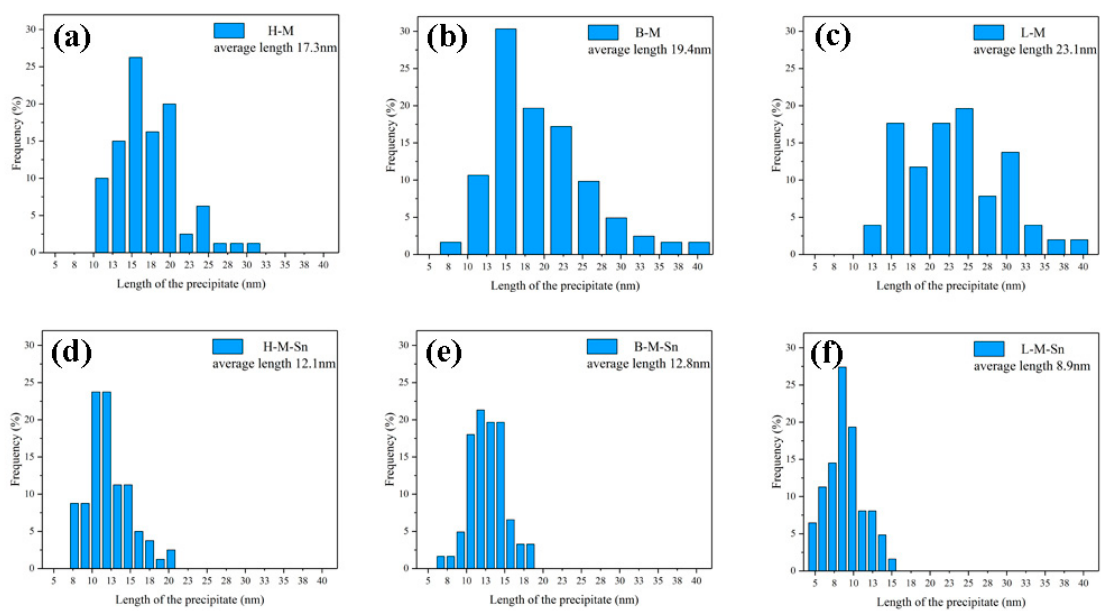
Figure 4. Average length and length distribution of the β″ precipitates in the peak aged alloys: ( a ) H–M; ( b ) B–M; ( c ) L–M; ( d ) H–M–Sn; ( e ) B–M–Sn; ( f ) L-M–Sn.